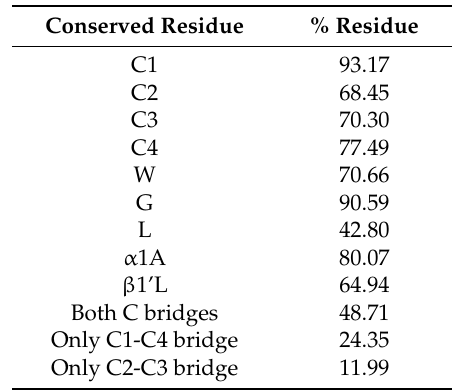
Table 3. Presence of conserved residues in nematode CTLDs. The first column shows the nine different conserved residues. The second column indicates the share of sequences that contain the respective residue. The last three rows show the share of the different combinations of disulfide bridges in the investigated nematode sequences. C1-C4: conserved cysteine residues forming the disulfide bridges (C1-C4 and C2-C3 bridge). W, G, and L: conserved residues from the “WIGL” motif. α 1A: conserved alanine residue in the first α -helix of the C-type lectin fold. β 1’L: conserved leucine residue in the first β -sheet of the C-type lectin